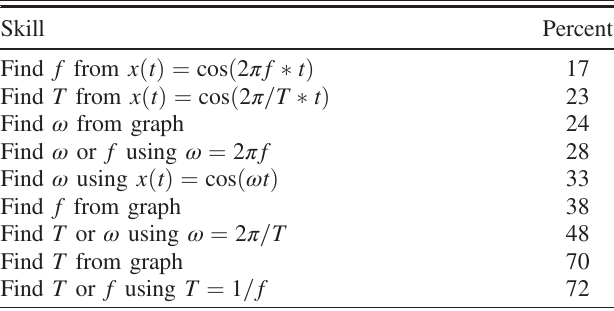
TABLE VI. Percent of the algebra-based students having mastered each of the nine